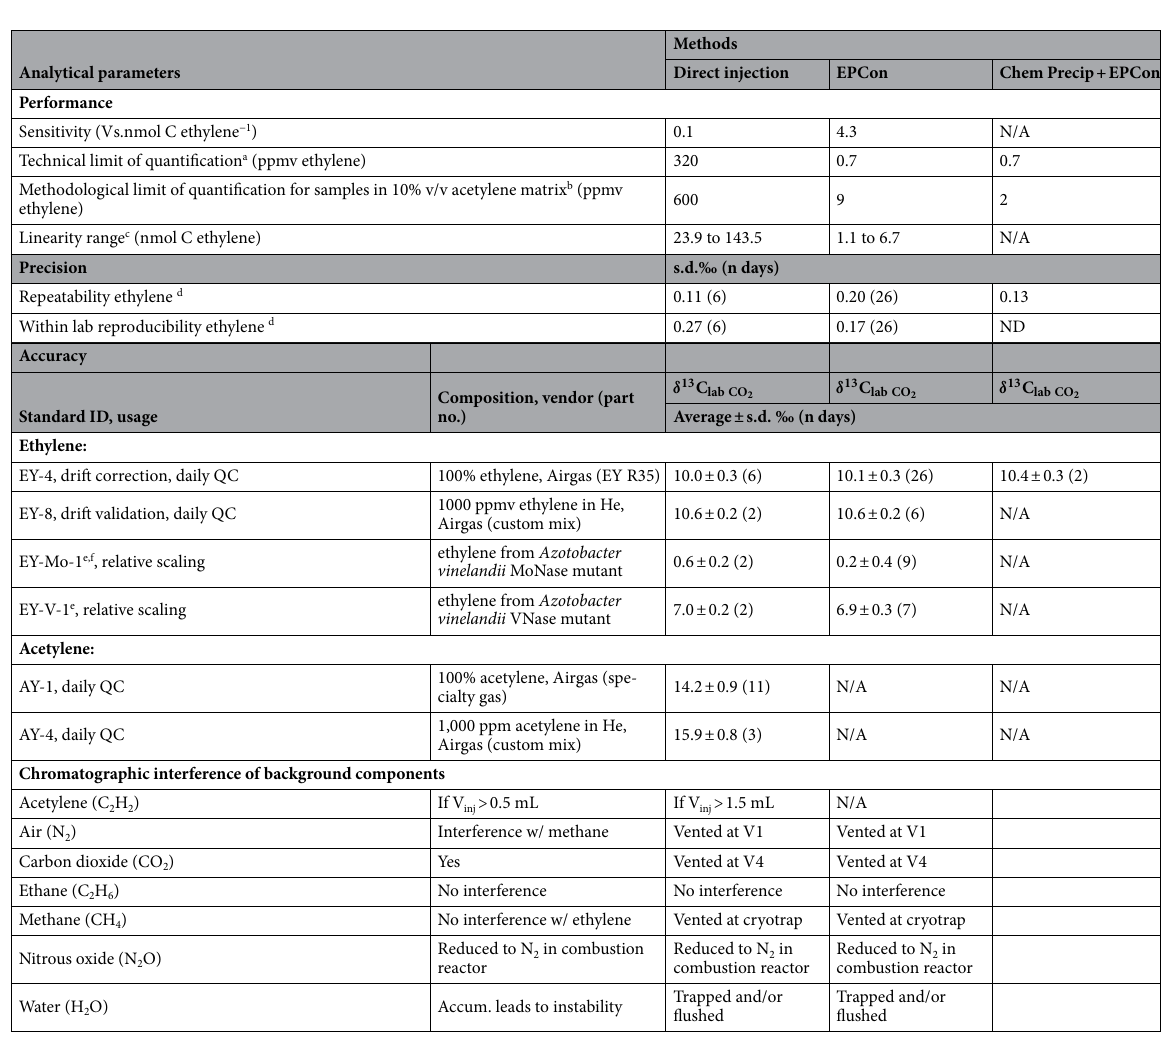
Table 1. Analytical performance of Direct Injection, EPCon, and Chemical Precipitation + EPCon methods for δ 13 C measurements of ethylene. All parameters reported here were obtained under conditions typical of a controlled laboratory environment (e.g. relative humidity between ~ 20 and 60%, temperature at 21 ± 2 °C). Accuracy statistics are reported only for days when a particular standard was measured at least three times. See Supplementary DATA 1, tab “Supporting data for Table 1” for the full data set. a constrained by the minimum accepted peak amplitude (1 V for mass 44) and the maximum loading volumes for each method, 1 mL for direct injection, and 20 mL for EPCon and Chemical precipitation. b set by the maximum loading volume without overloading the system with acetylene (0.5 mL for direct injection and 1.5 mL for EPCon), and for Chemical precipitation, by the overprinting of sample δ 13 C with background ethylene carried over in acetylene generated from calcium carbide (~ 2 ppm). c conservative range of acceptable mass 44 peak amplitudes is 1–6 V. d corrected for instrumental drift. e corrected for background ethylene in acetylene generated from calcium carbide. f corrected for Rayleigh